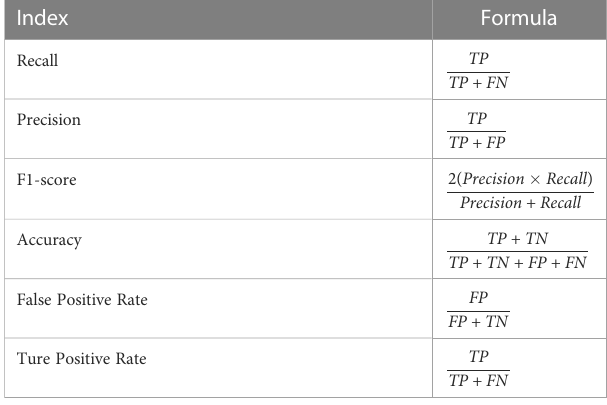
TABLE 3 Performance indexes used for the evaluation and comparison of the estimated model.